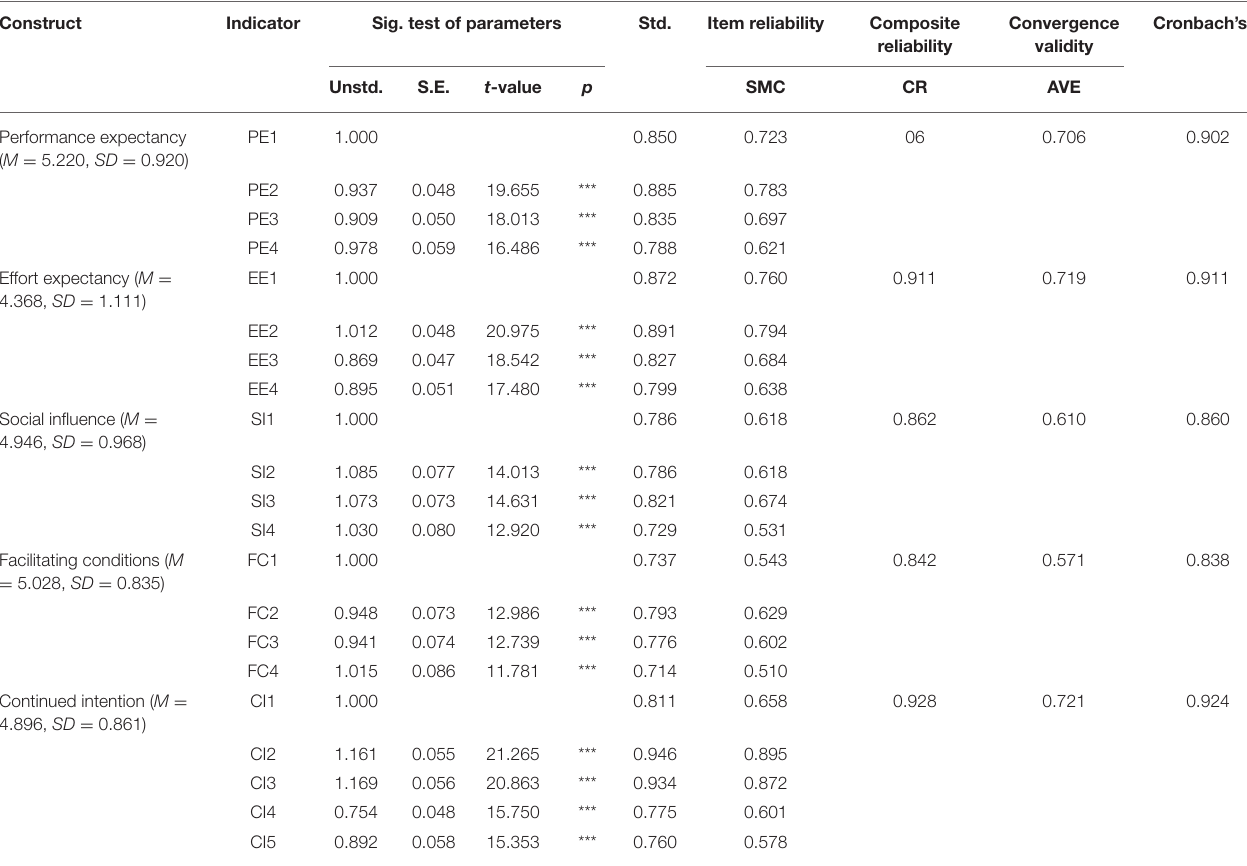
TABLE 3 | Reliability and convergent validity of UTAUT scale ( n = 312). Construct Indicator Sig. test of parameters Std. Item